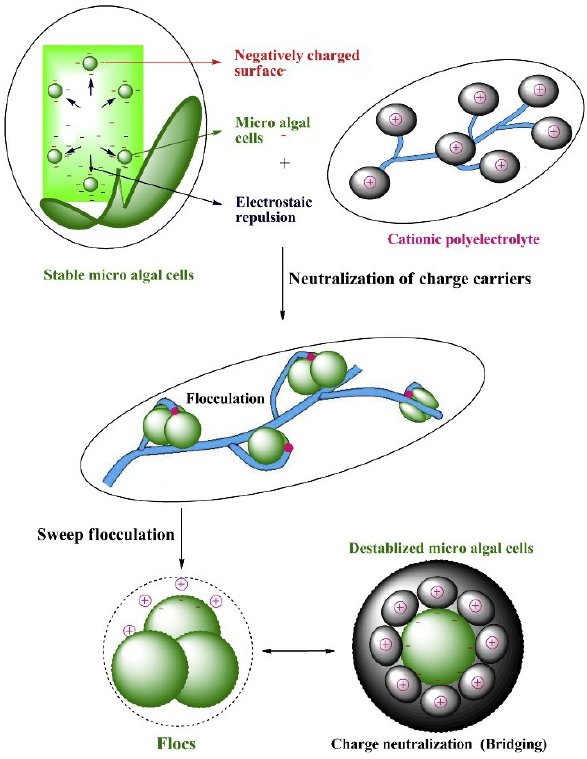
Figure 4. A schematic diagram of chemical flocculation harvesting of microalgae using a cationic polyelectrolyte. Reprinted from Reference [29], distributed under the terms of the Creative Commons Attribution License. Table 3. Comparison of inorganic and organic chemical flocculants for algae harvesting.